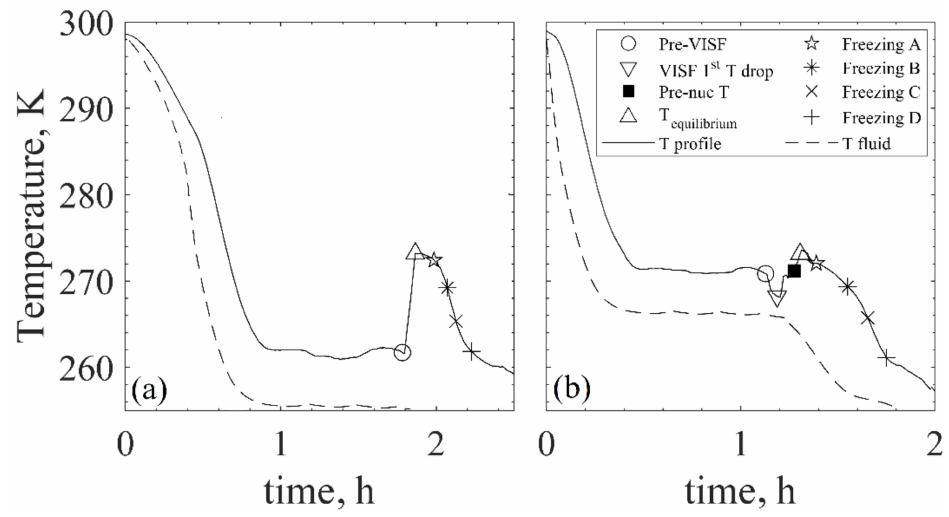
Figure A2. Representation of the points of interest during freezing for spontaneous nucleation ( a ) and VISF tests ( b ) that are used in Figure